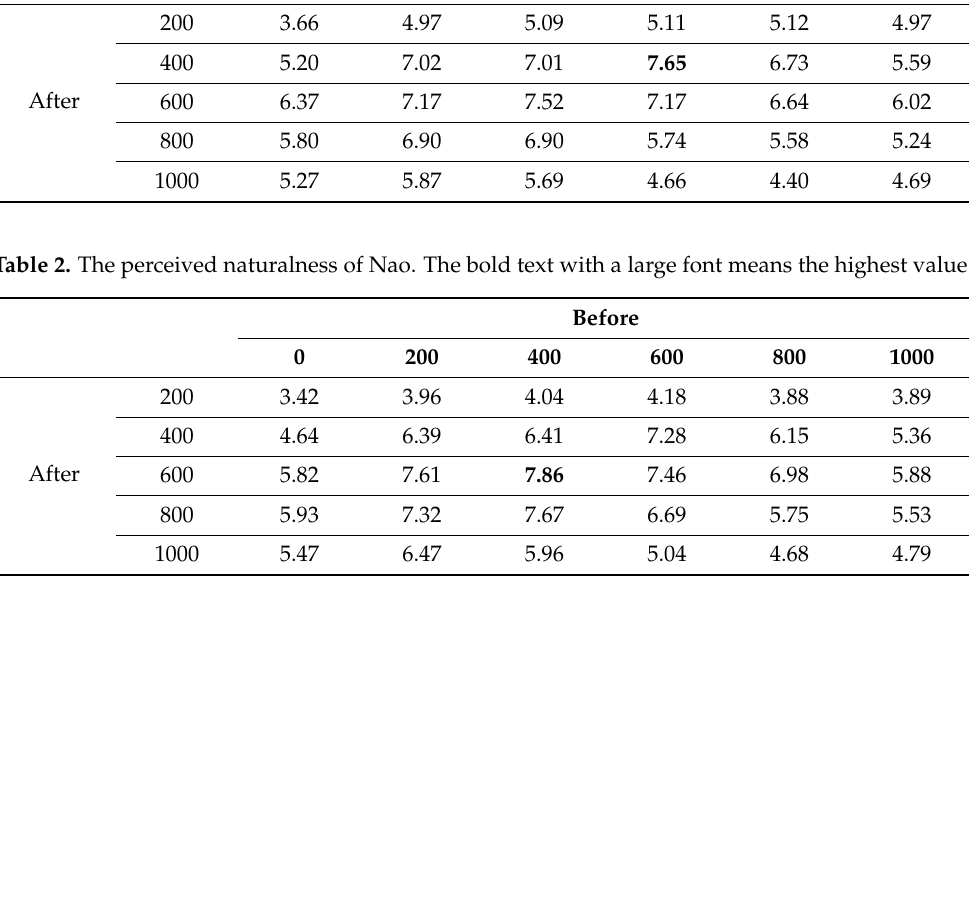
Figure 6. Questionnaire results of perceived naturalness. In the table, the bold text with a large font means the highest value in each model. ( a ) Sota, ( b ) Nao, ( c ) Pepper, ( d ) Male, ( e ) Female. Table 1. The perceived naturalness of Sota. The bold text with a large font means the highest value. Before 0